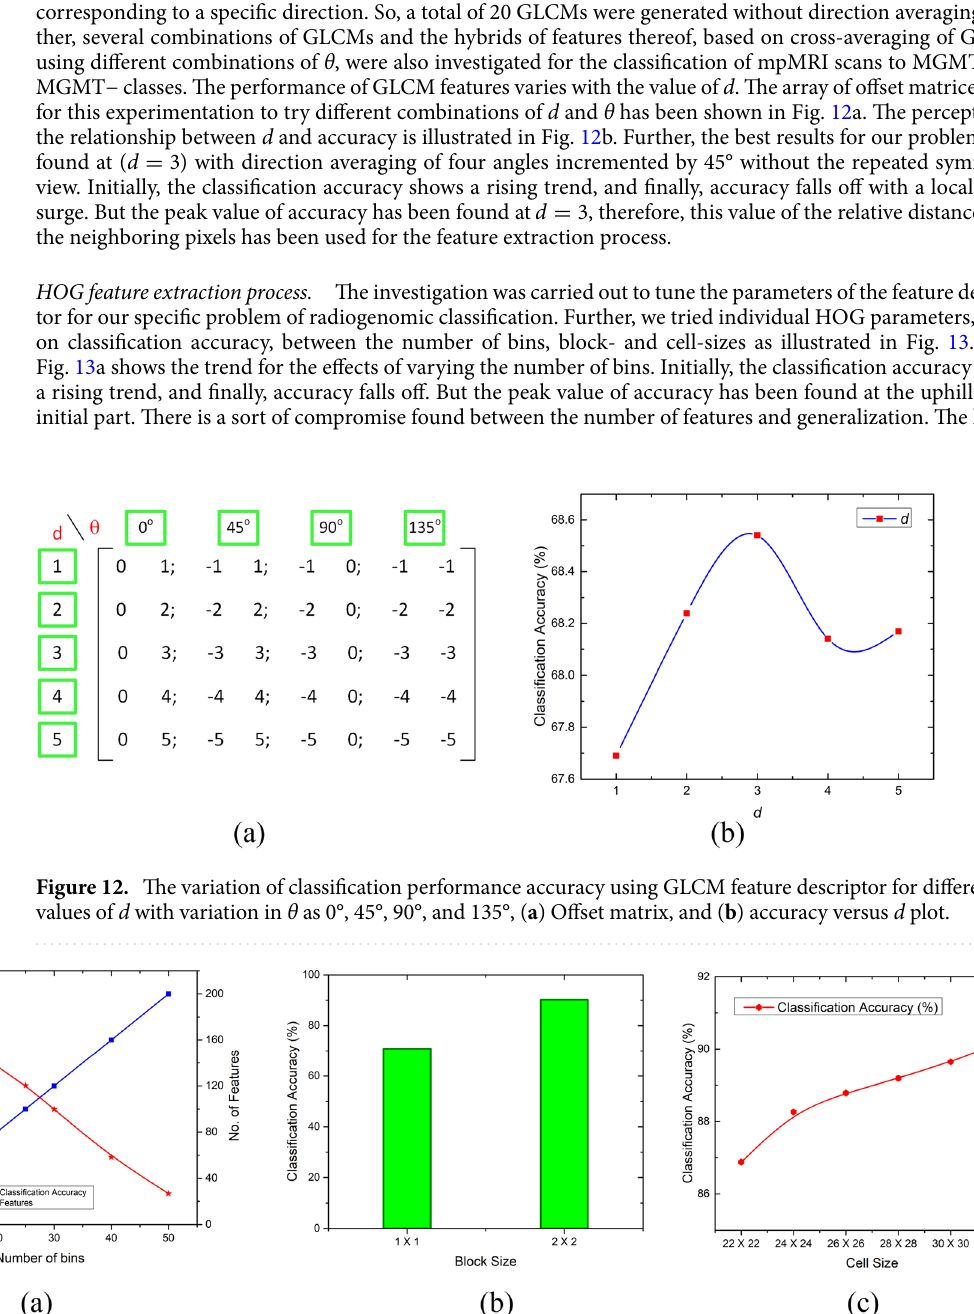
Figure 13. Sensitivity analysis of HOG parameters for radiogenomic classification: ( a ) number of bins, ( b ) block size, and ( c ) cell